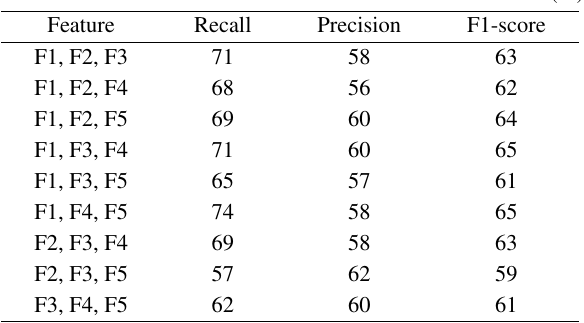
Table 5 Comparison of three different combinations of features for RBF kernel.